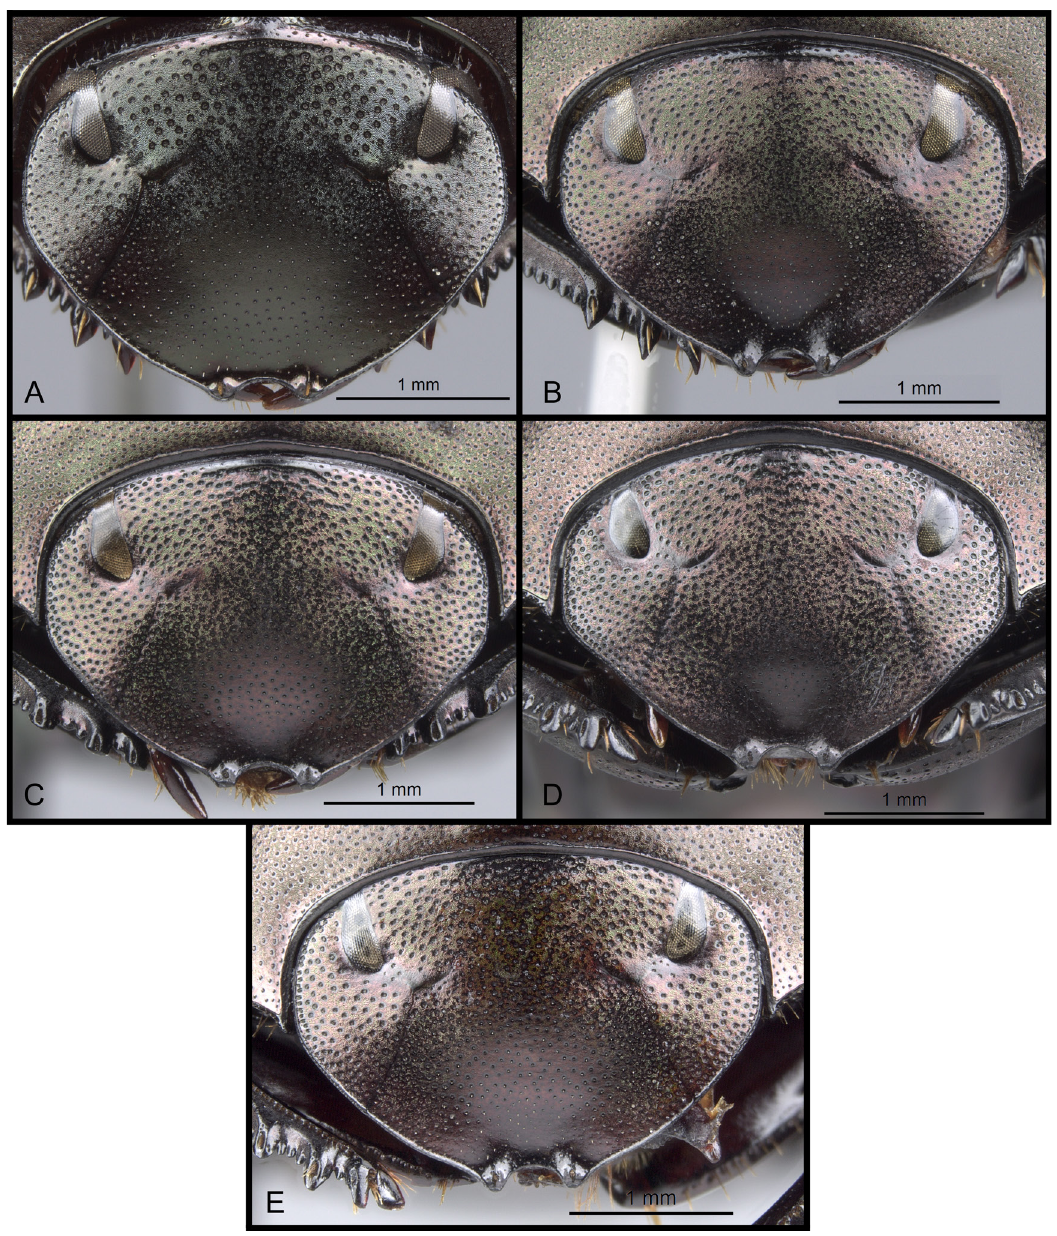
Fig. 2. Head of members of the gilli species group. A . Holotype of Deltochilum gilli González- Alvarado & Vaz-de-Mello, 2021, CNCI 379888. B . Holotype of D. jocelynae sp. nov., CNCI 379889. C . Holotype of D . nonstriatum sp. nov., CMNEN WSD00041746. D . Holotype of D . quasistriatum sp. nov., CMNEN WSD00041744. E . Holotype of D . tenuistriatum sp. nov., CMNEN